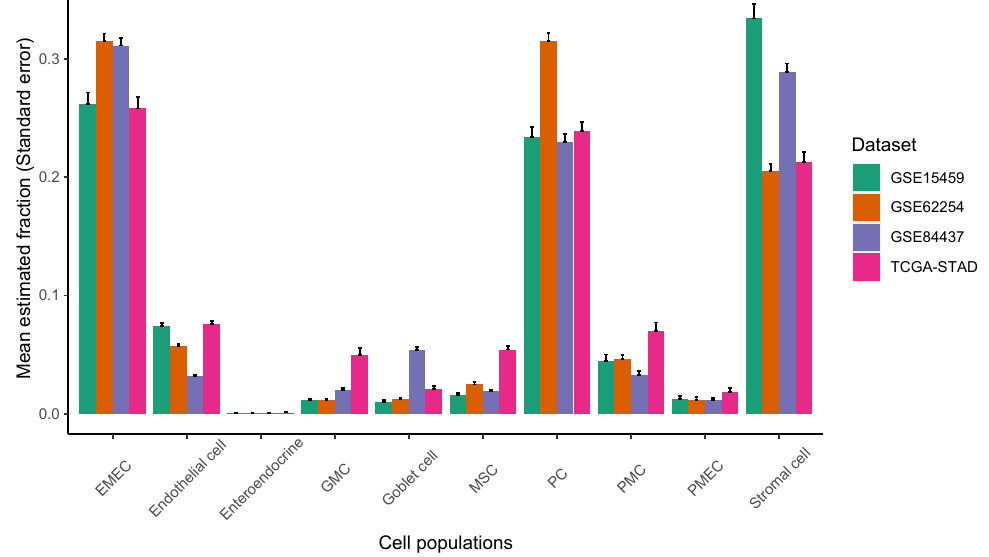
Figure 5. The relative abundance of major classes of non-immune cell populations for four cohorts of gastric cancer